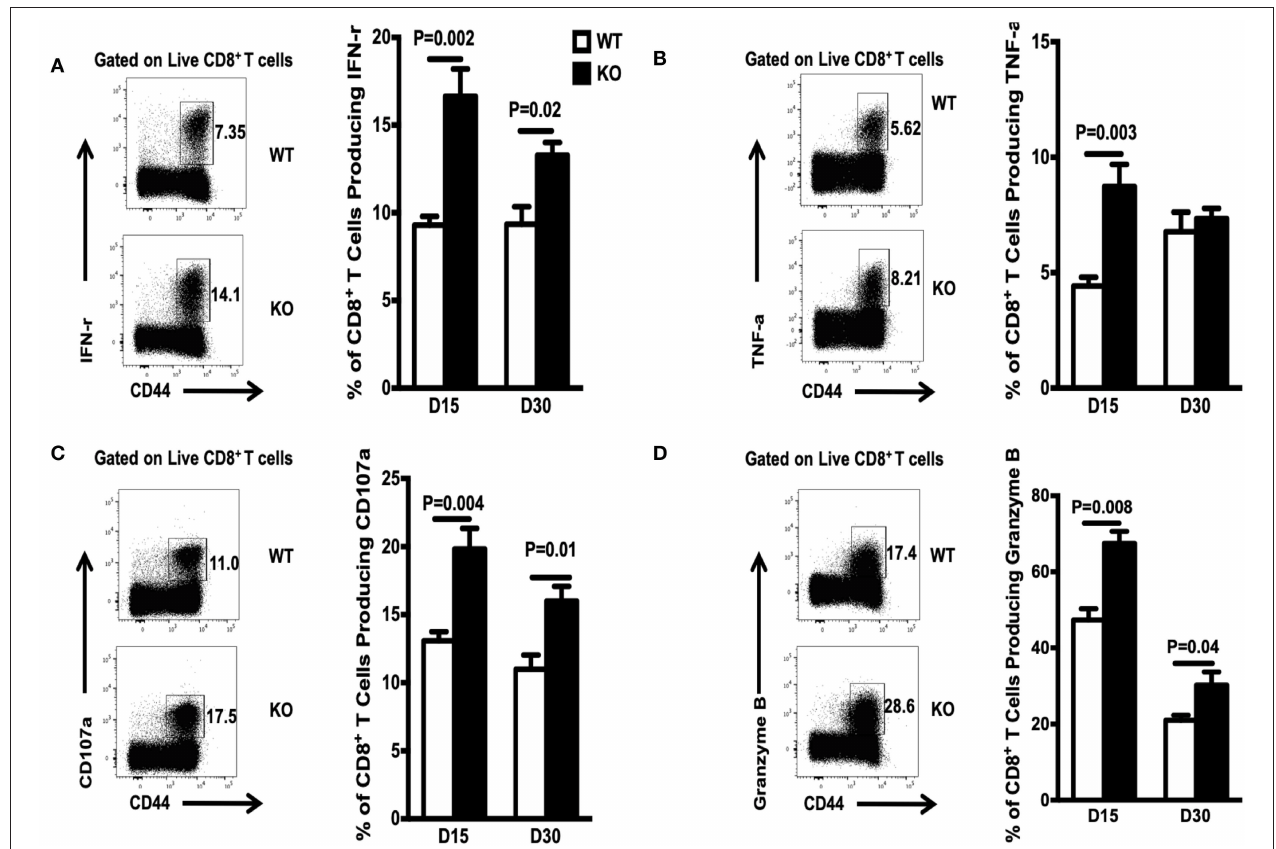
FIGURE 4 | Increased accumulation of cytokine-producing CD8 + T cells during the contraction and early memory stages in WASp − / − mice. On D15 and D30 after LCMV infection, spleenocytes were stimulated with GP33-41 peptide in vitro and Ag-induced cytokine production was measured by intracellular staining. Representative data showing cytokine production on D30. (A) Percentage of IFN- γ -producing cells within the CD8 + T cell population. (B) Percentage of TNF- α producing cells within the CD8 + T cell population. (C) Percentage of CD107- α producing cells within the CD8 + T cell population. (D) Percentage of Granzyme B-producing cells within the CD8 + T cell population. Data are expressed as the mean ± SEM ( n = 5 mice per group) and were analyzed using an unpaired t